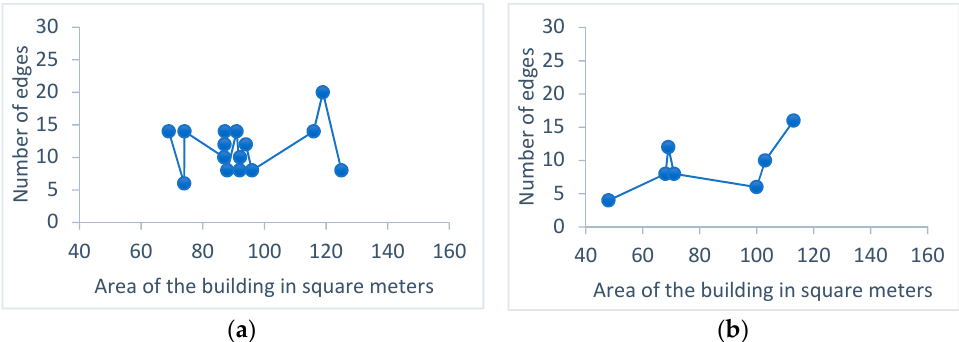
Figure 12. Efficiency observed based on the number of edges that are necessary to draw the shape of the building boundary. ( a ) Results of real-life buildings in the research paper by Wu et al. [13] show high variety with 11.46 as the average number of edges. ( b ) Results of the method by Wu et al. [13] have a value of 7 for the average number of edges.